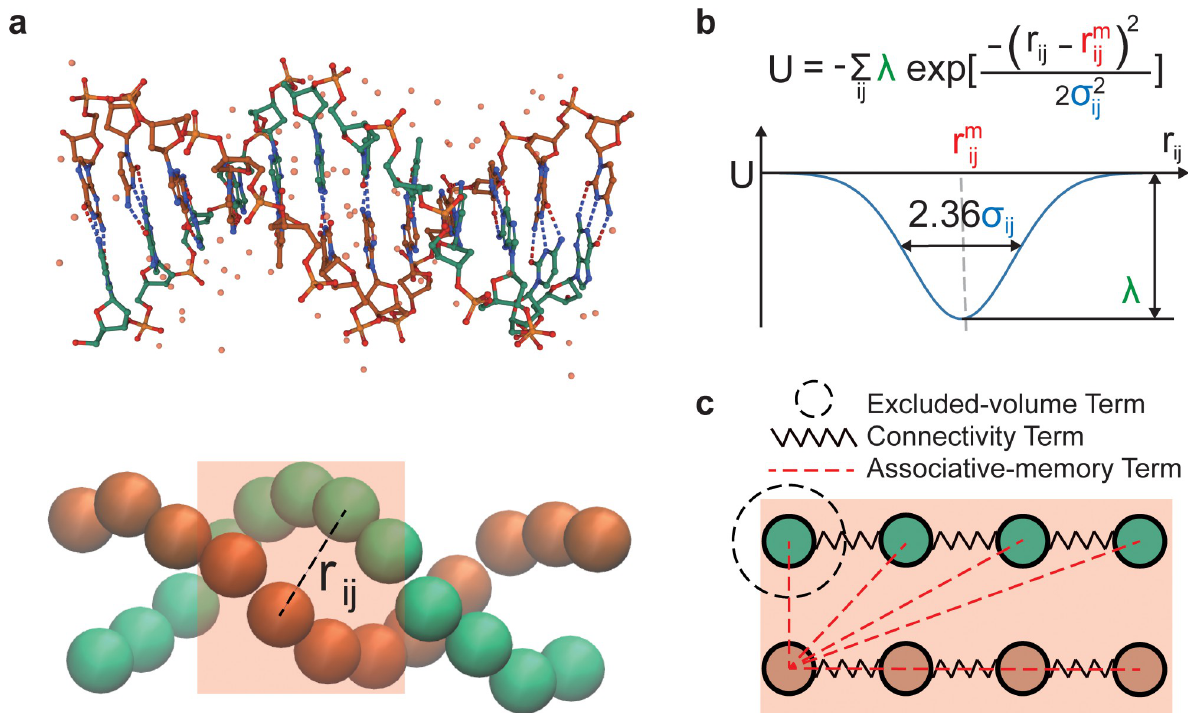
Fig 1. An Associative Memory Hamiltonian for DNA. (a) Comparison of an atomistic representation and a coarse-grained representation of a B-DNA dodecamer (PDB ID: 1BNA [55]). (b) The AMH recapitulates the energy landscape of the DNA molecule using a series of Gaussian wells. The parameters r m are determined using the distances measured in the structural memories, while the energy of interactions, λ and the scale of ij structural fluctuations, σ , are tuned to reproduce experimental observables. (c) Schematic representation of the energy terms in the model: connectivity (springs), excluded-volume terms (dashed circle), and AMH terms encoding the double helix structure (red dashed lines). An AMH term is applied between any pair of particles inside the box of 4bp. The box is then slid along the DNA, and the procedure is repeated.